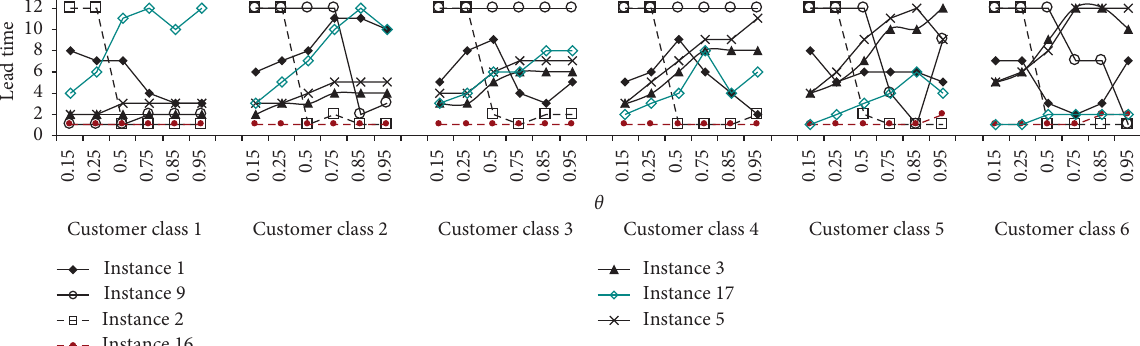
Figure 9: Comparison of the optimal quoted lead time in centralized dual-channel supply chain for different instances. Table 4: Comparison of retailer and direct prices under both decentralized and centralized supply chain. P r − P r II I Problem number